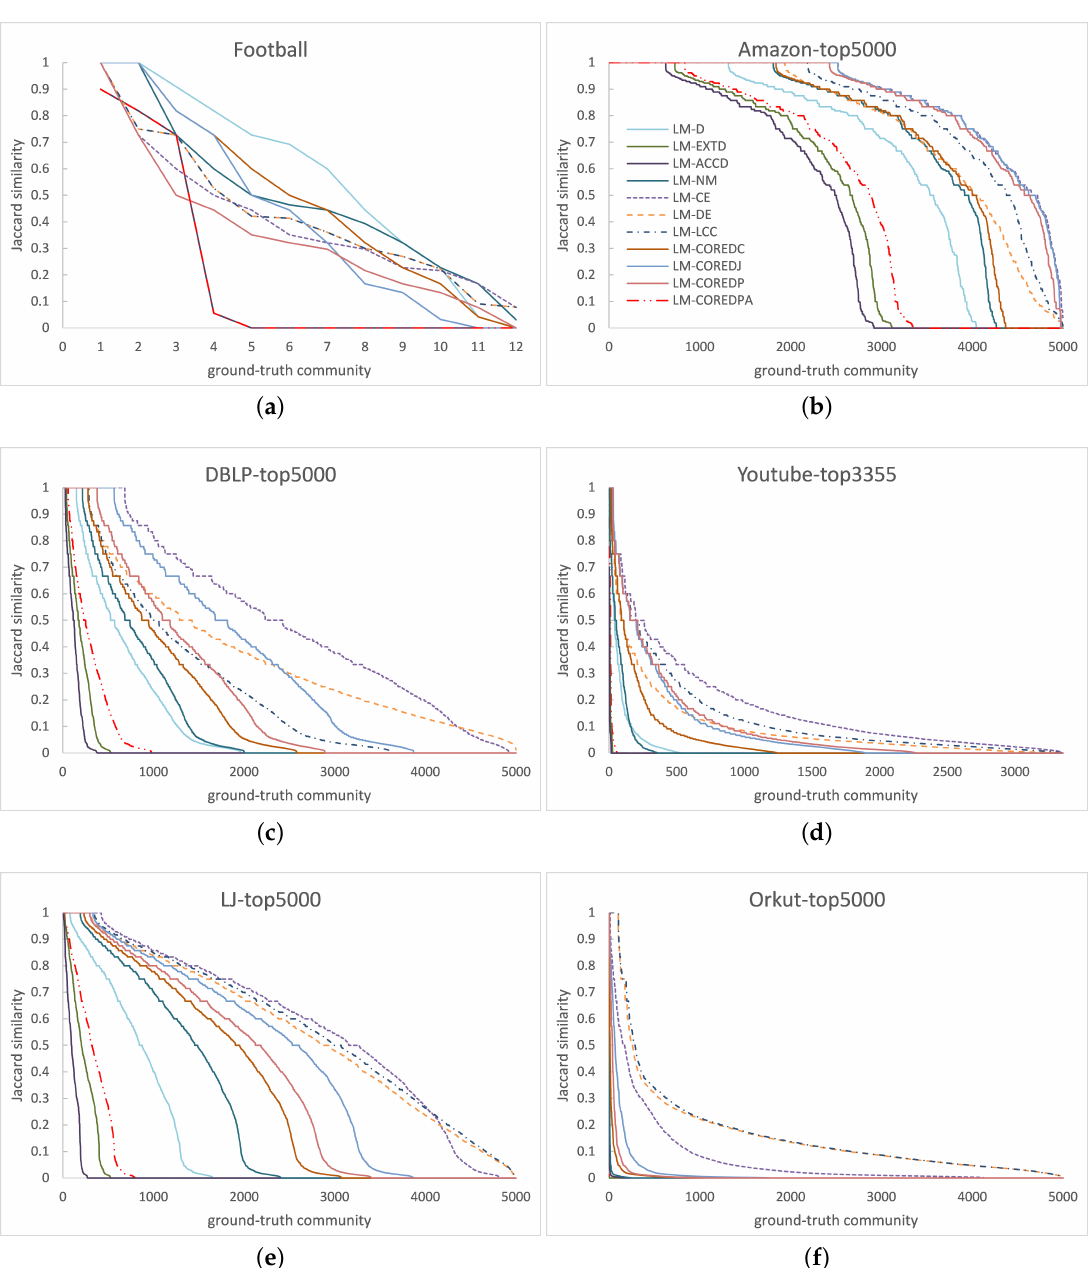
Figure 4. Similarity of the detected communities resulting from different local seeding algorithms to the (top) ground-truth communities. The y-axis is the Jaccard similarity between ground-truth com- munity and the corresponding detected community, and the x-axis depicts ground-truth community ranked by